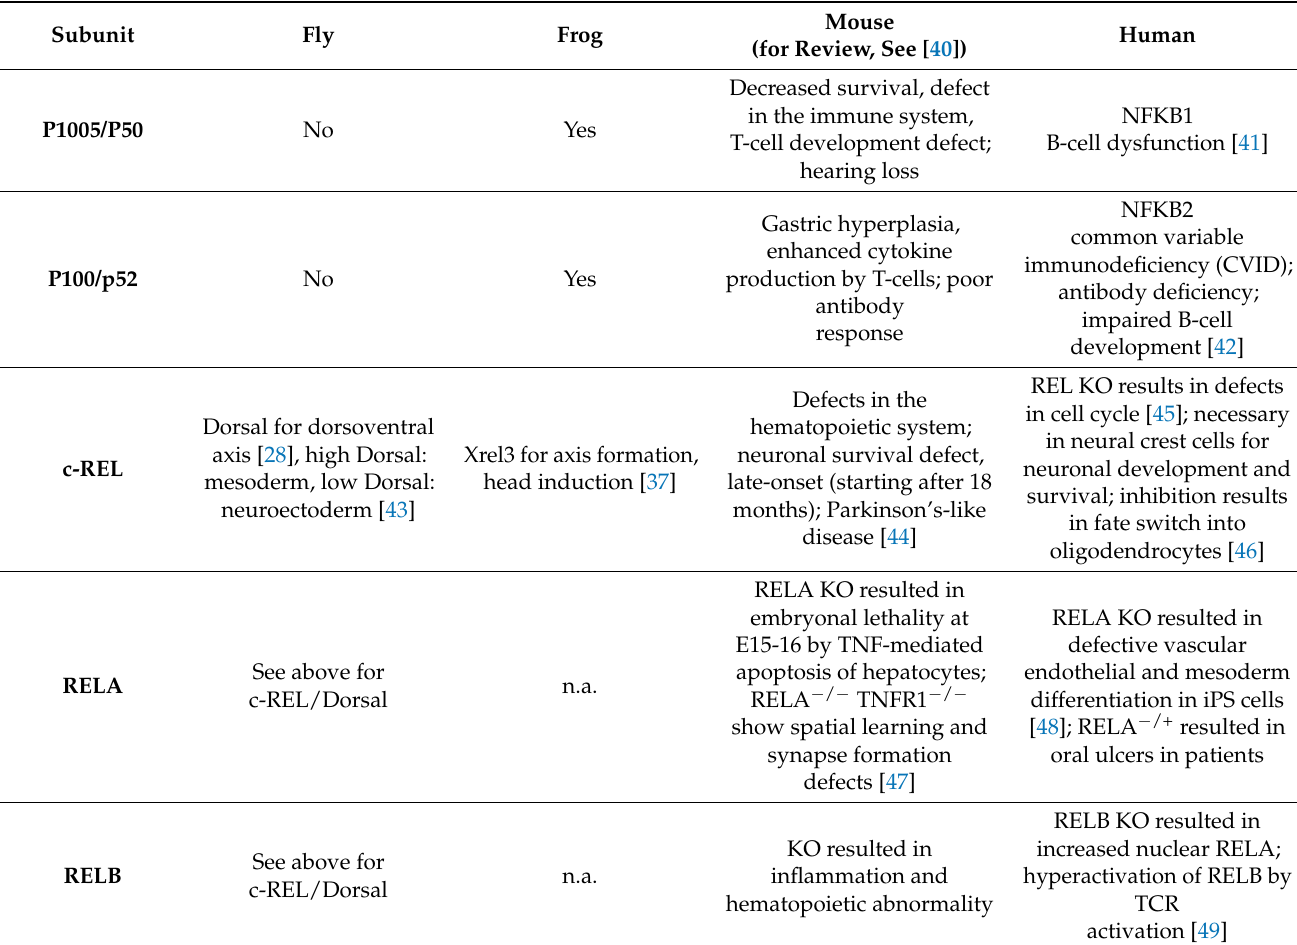
Table 1. Cellular phenotypes related to genetic NF- κ B defects detected among different